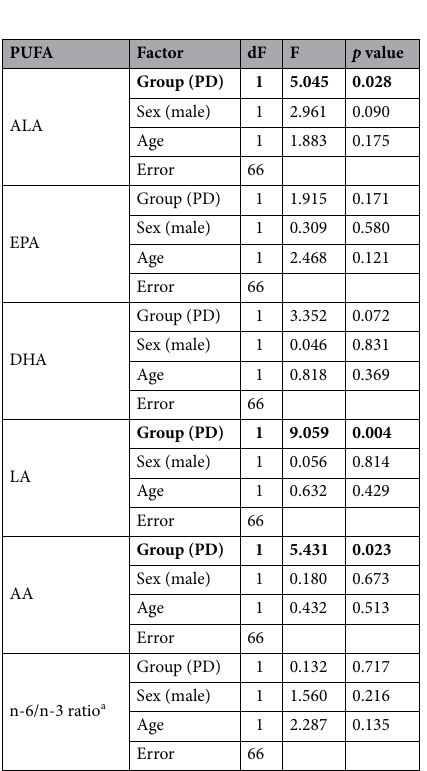
Table 2. Results of ANCOVA for individual PUFA after controlling for age and sex. The values marked in bold indicate statistically significant differences. ANCOVA analysis of covariance, PUFA polyunsaturated fatty acid, ALA alpha-linolenic acid, EPA eicosapentaenoic acid, DHA docosahexaenoic acid, LA linoleic acid, AA arachidonic acid. a n-6/n-3 ratio = (LA + AA)/(ALA + EPA +